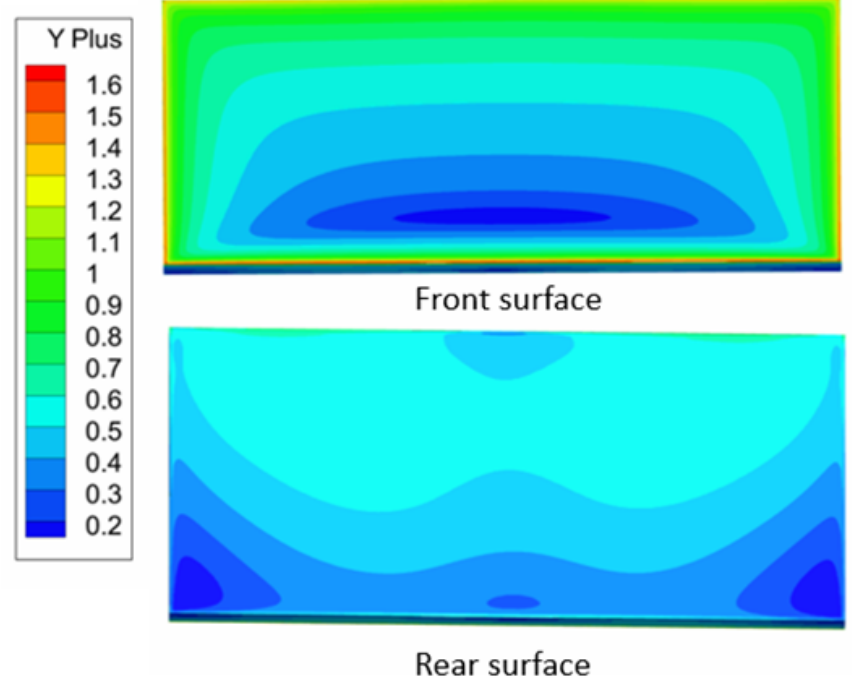
Figure 6. Dimensionless y+ contours over the PV surfaces at an inlet velocity of 10 m/s. The main grid shapes of the computational domain and around the PV panel are shown in Figure